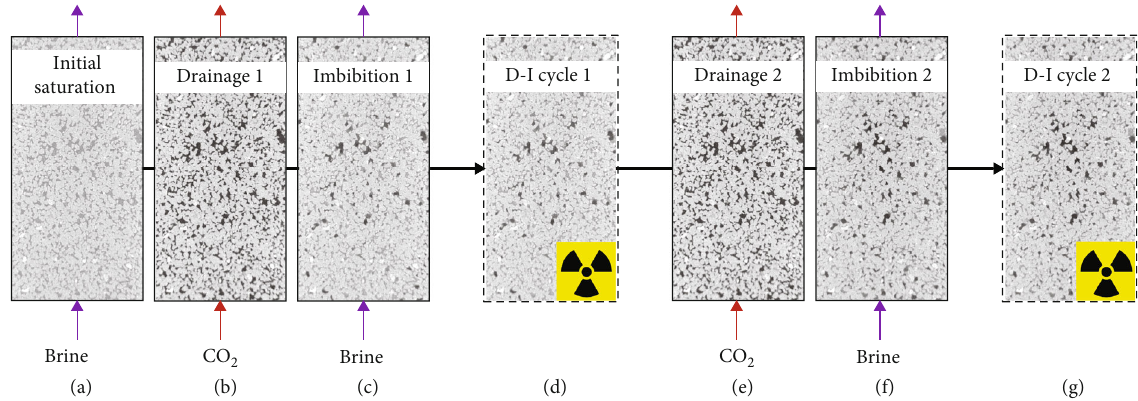
Figure 1: Drainage-imbibition cycle infographic: (a) initial brine saturation, (b) fi rst CO CT scan of D-I cycle 1 (residual saturation 1), (e) second CO 2 (residual saturation